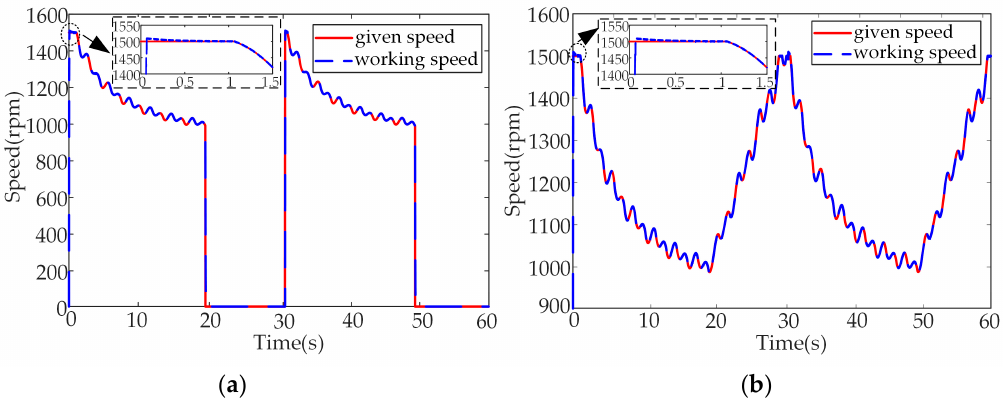
Figure 7. Speed under PI control. ( a ) Speed of G1; ( b ) speed of G2.